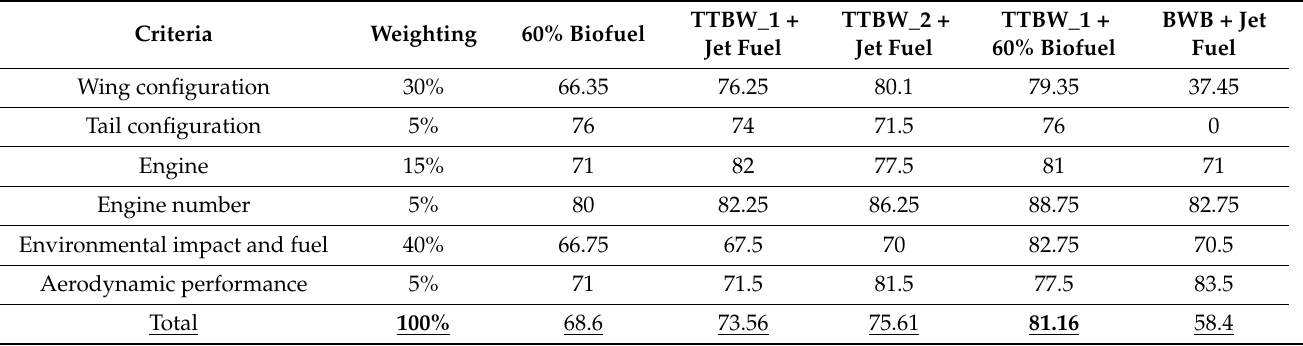
Table 2. Final configuration using PUGH